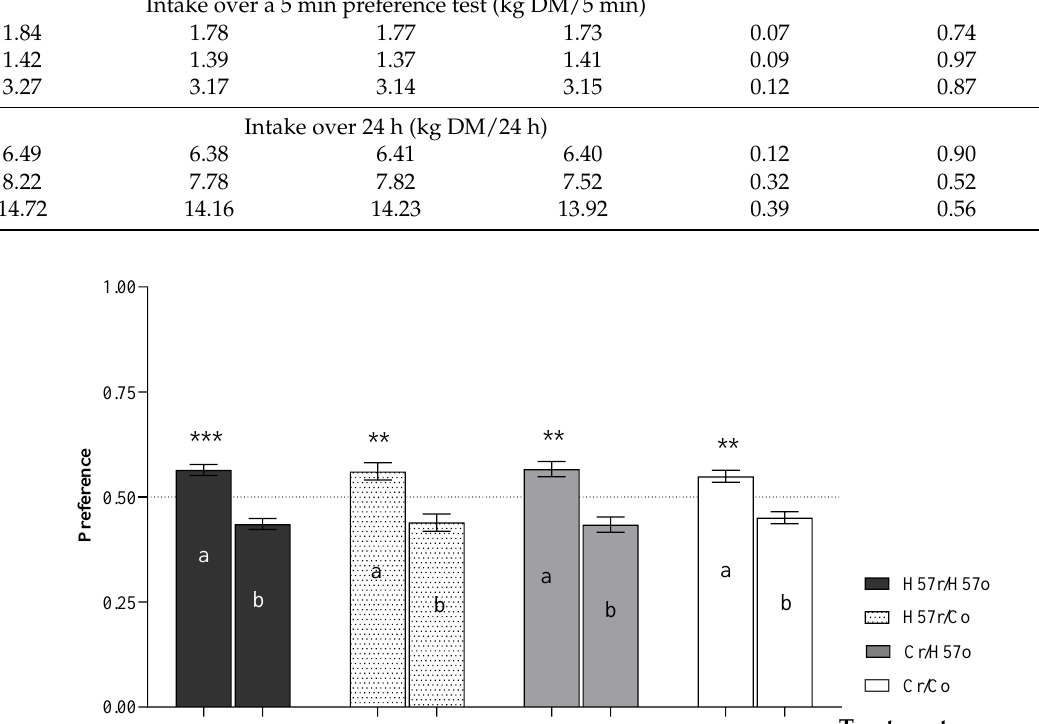
Figure 2. Preference of pellets during the 5 min preference test following the addition of H57 or C pellets into the digestive system, either orally (o) or through a rumen fistula (r). Asterisks indicate significant differences from the theoretical 0.5 proportion of non-preference; **: p < 0.01; ***: p < 0.001. In the columns, a, b values within the base-feeding treatment differ at p < 0.05; error bars represent s.e.m.